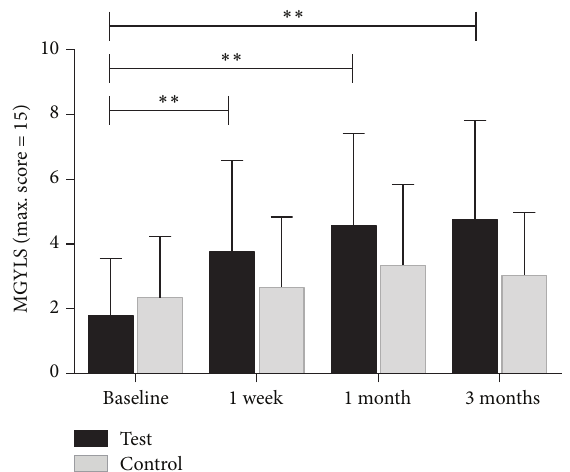
Figure 8: The mean value of test-eye meibomian glands yielding liquid secretion (MGYLS) measured at baseline, at one week, at one month, and at three months ( ∗∗ 𝑝 < 0.001 ).